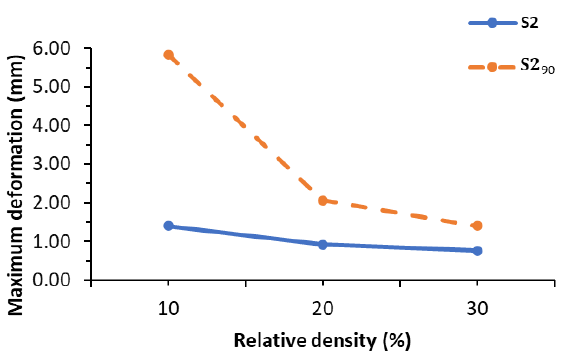
Figure 8. Maximum deformation results of S2 and S2 90 .